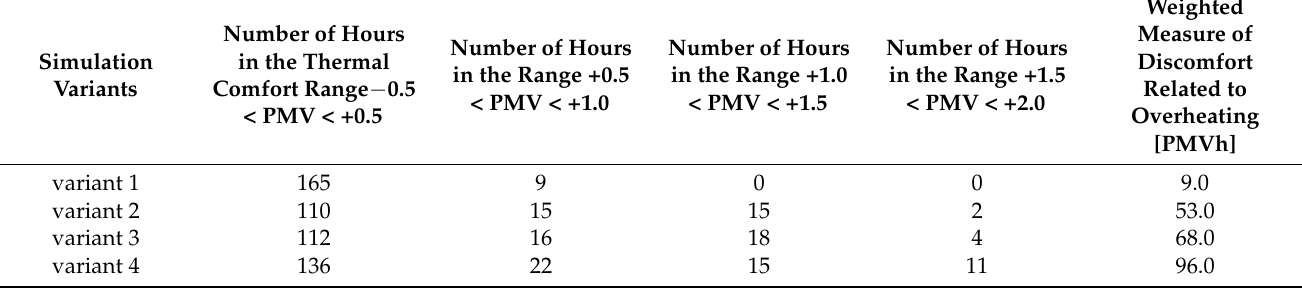
Table 5. Hourly distribution of the predicted mean vote (PMV) index for the adopted simulation variants.